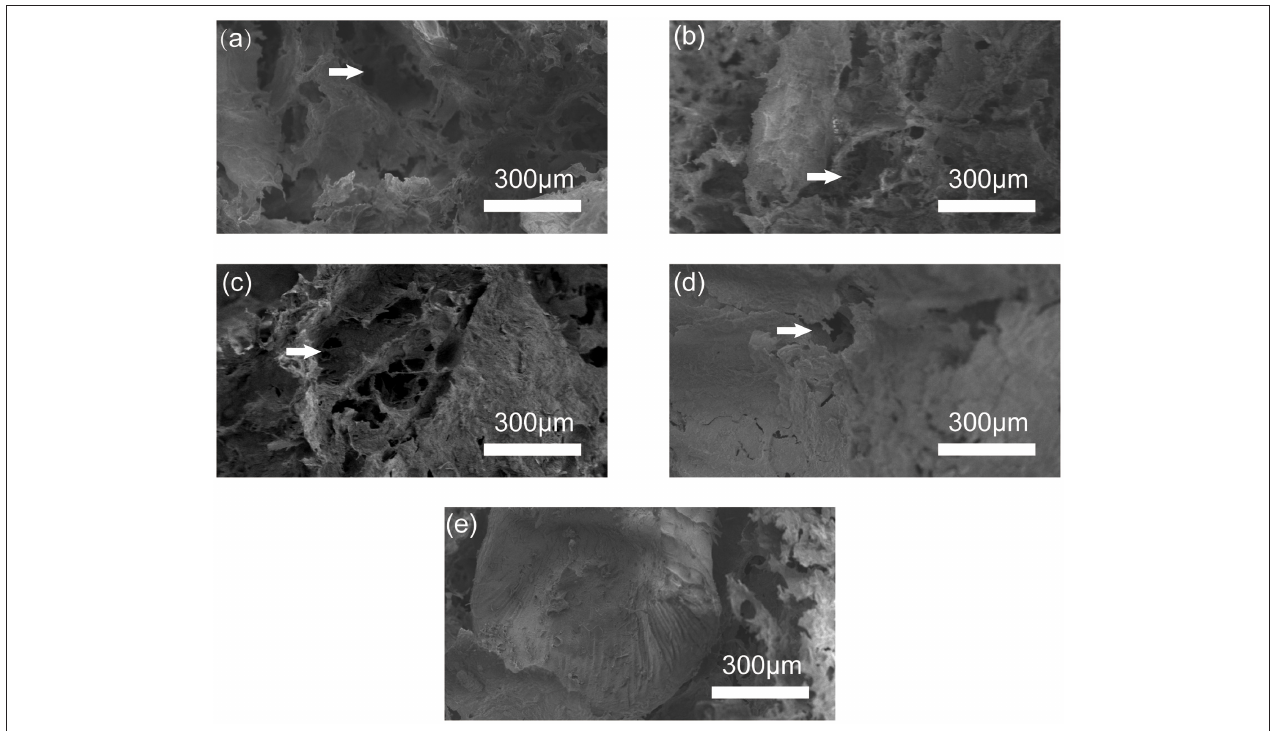
FIGURE 3 | SEM image of (a) HA 4 (SA/CS) 6 scaffold, (b) HA 5 (SA/CS) 5 scaffold, (c) HA 6 (SA/CS) 4 scaffold, (d) HA 7 (SA/CS) 3 scaffold, and (e) microsphere inside the scaffold.